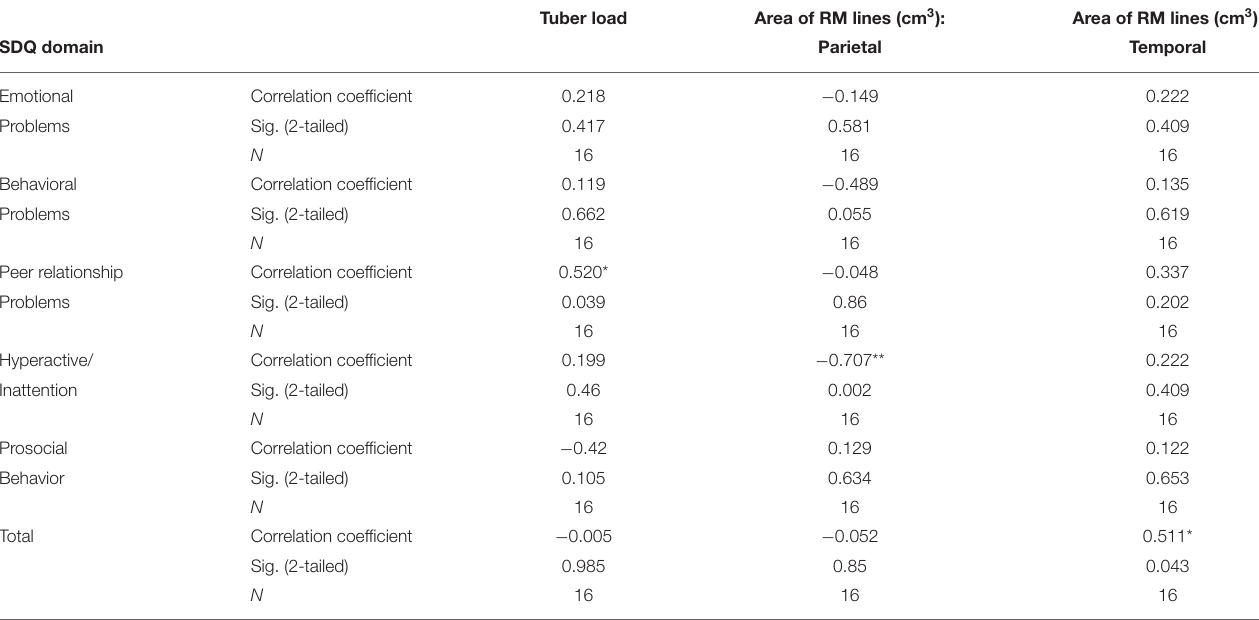
TABLE 5 | Correlations of tubers and radial migration (RM) lines with scores on the Strength and Difficulties Questionnaire (SDQ) in individuals with tuberous sclerosis complex. Tuber load Area of RM lines (cm 3 ): Area of RM lines (cm 3